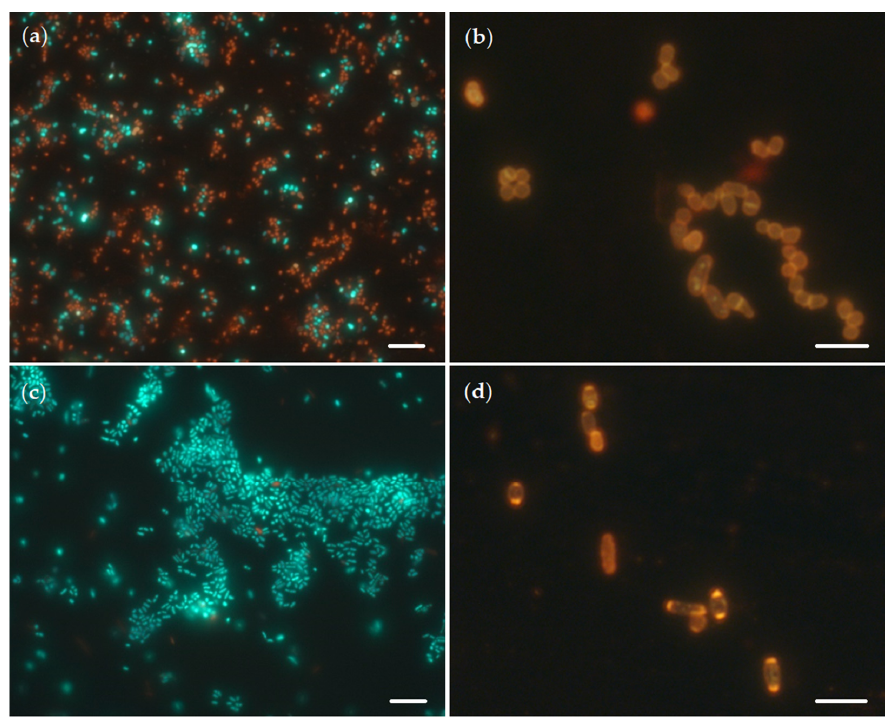
Figure 5. Fluorescent microscopy (×1000) of R. rhodochrous IEGM 757 cells stained with Live/Dead ( a , c ) and Nile Red ( b , d ) dyes in the presence of OA ( c , d ) and without it ( a , b ). Bars: 8 µm ( a , c ); 3 µm ( b , d ).